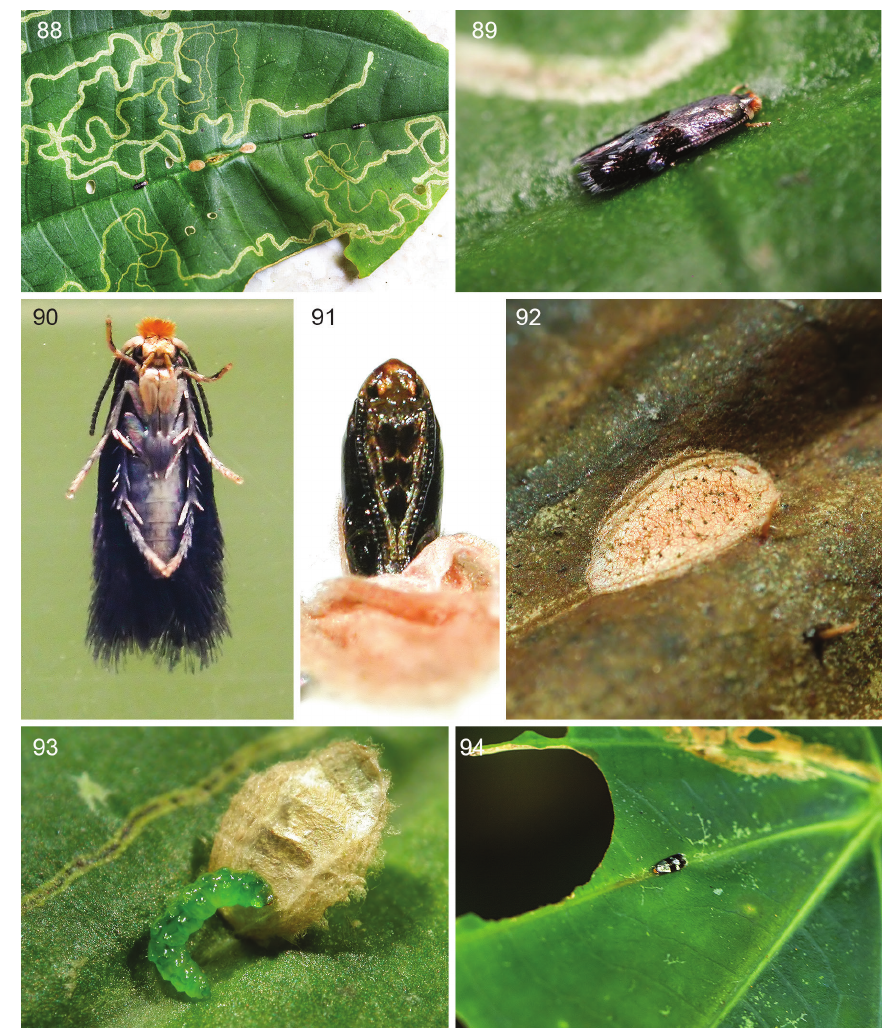
Figures 88–94. Ozadelpha conostegiae , life history details, Costa Rica, Estación Biológica Monteverde 1530 m. 88 Leaf mines, 2 cocoons and 3 adults on midrib on upperside host plant leaf, 29 March 2012 89 Close up of one adult male 90 Adult female resting on plastic bag under rearing conditions, ventral view, 1 December 2013 91 Pupa, ventral view, cocoon detached and removed, 7 June 2016 92 Cocoon spun on upperside on secondary vein under captive conditions, 7 June 2016 93 Cocoon-spinning mature larva, outer layer cocoon is removed to show larva, 19 June 2016 94 Ozadelpha specimen EvN4680, female, resting on upper side leaf along one of the primary veins, 3 February